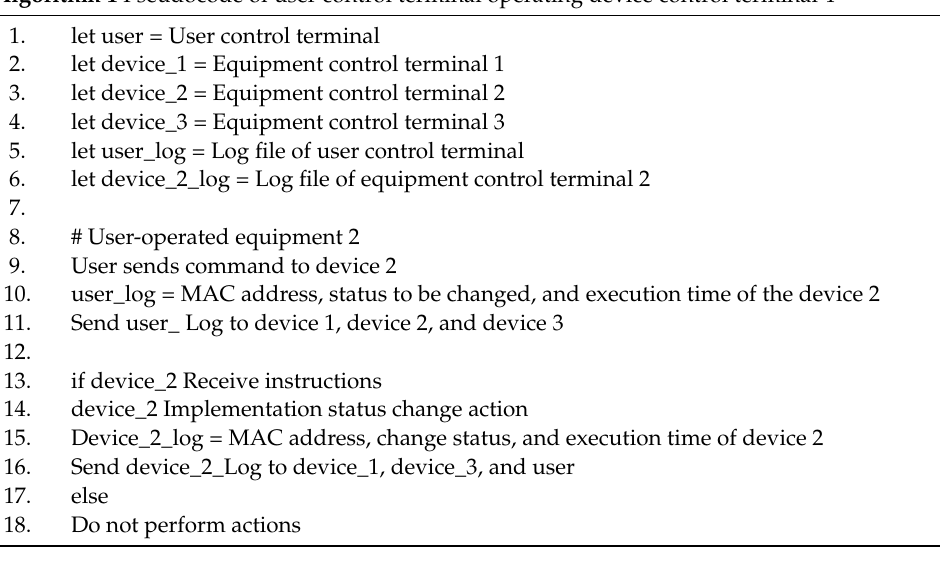
Algorithm 1 Pseudocode of user control terminal operating device control terminal 4